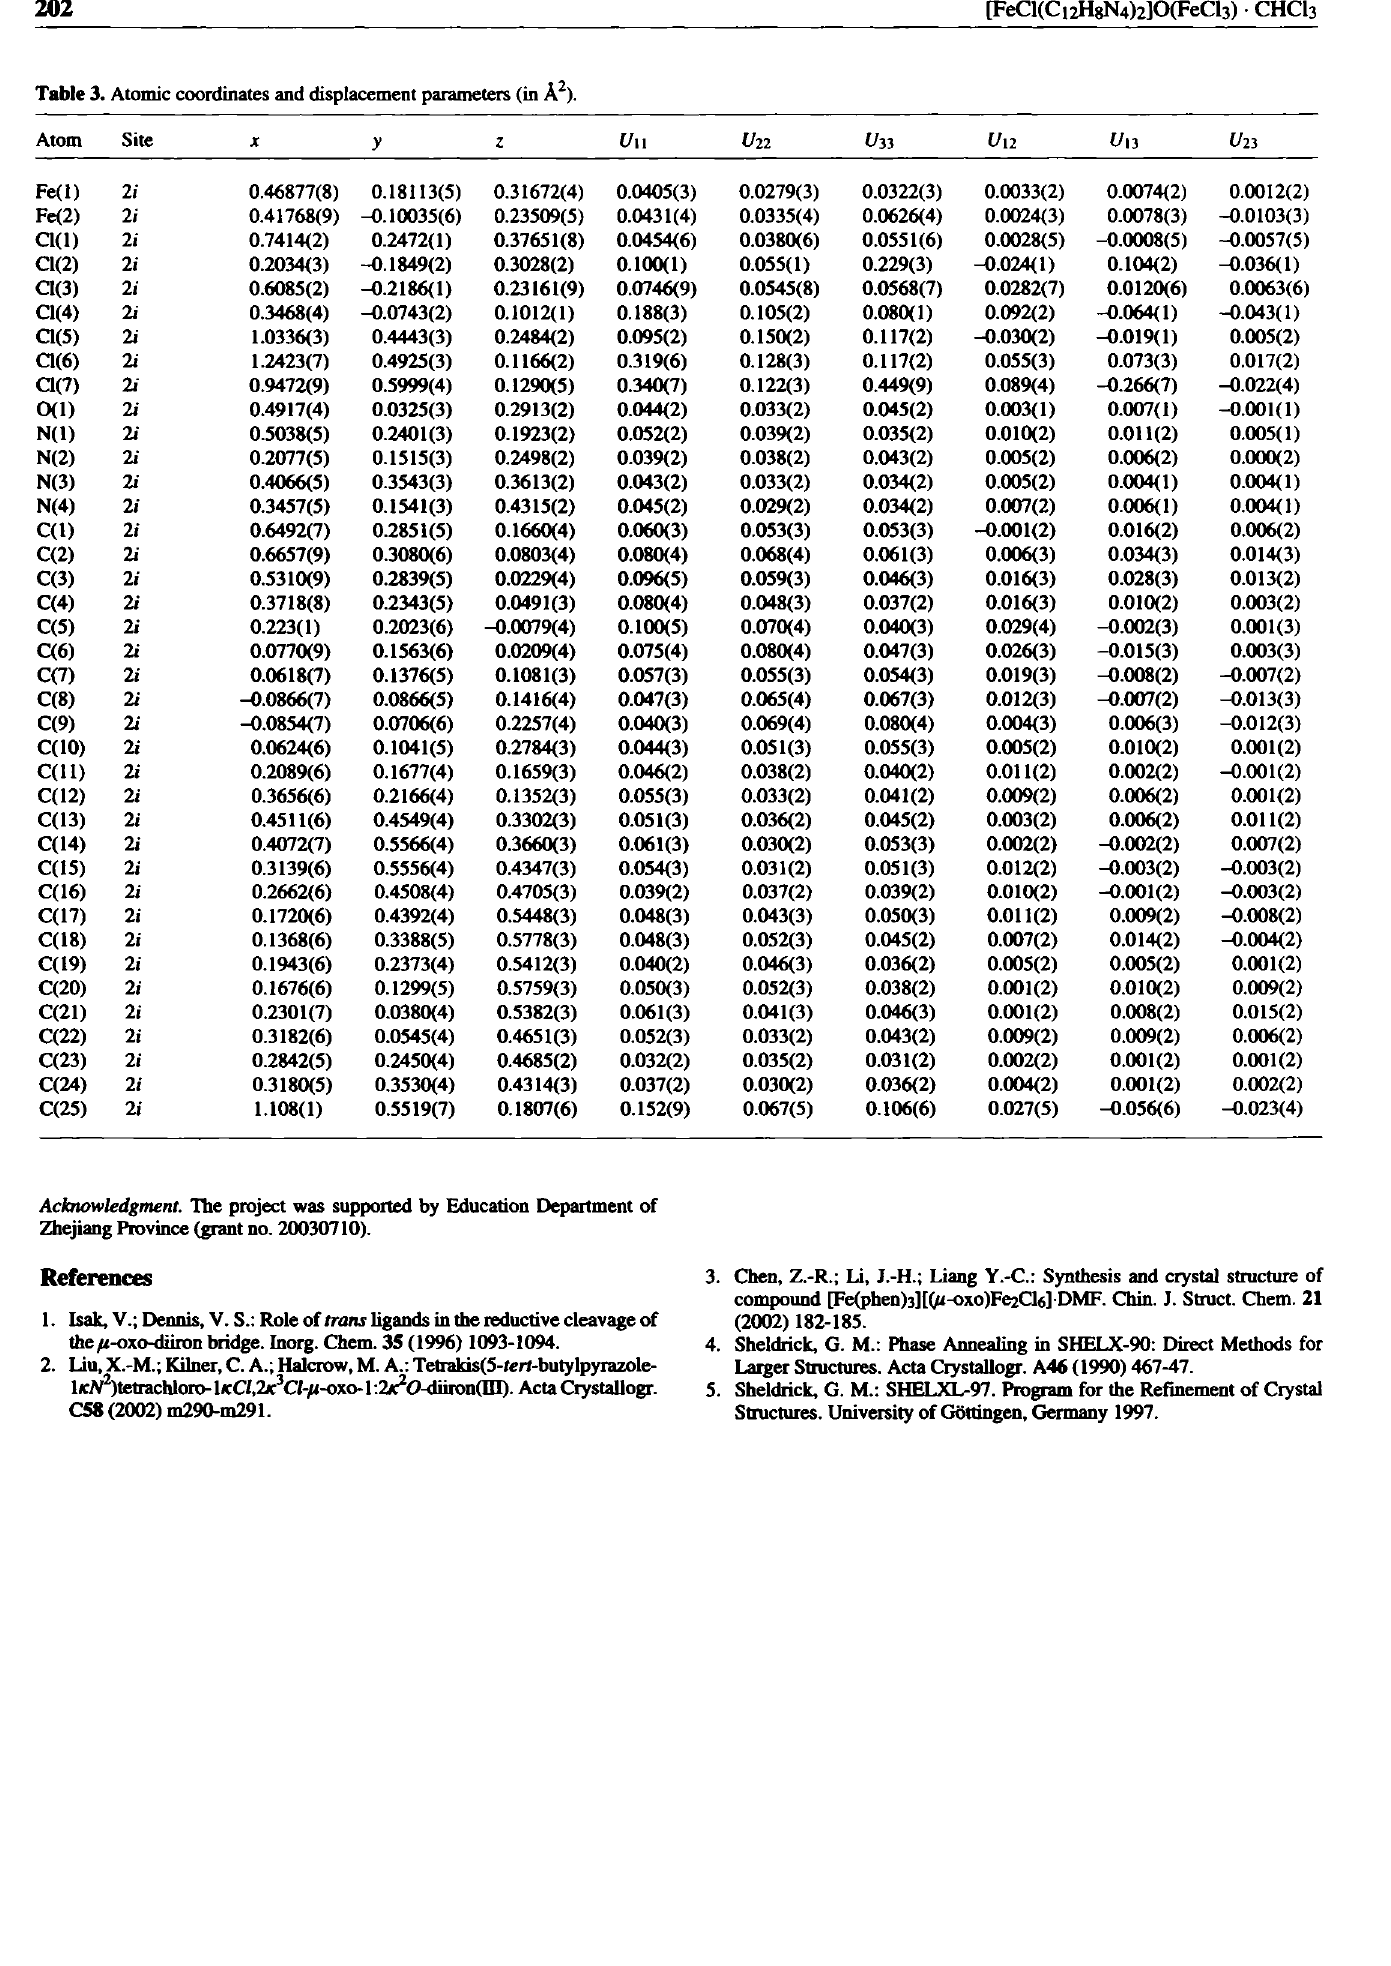
Table 3. Atomic coordinates and displacement parameters (in Ä 2